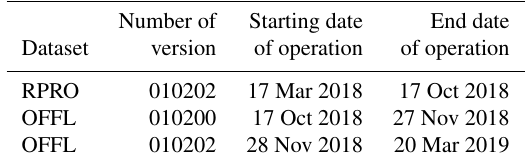
Table 6. TROPOMI NO 2 processor versions used in this